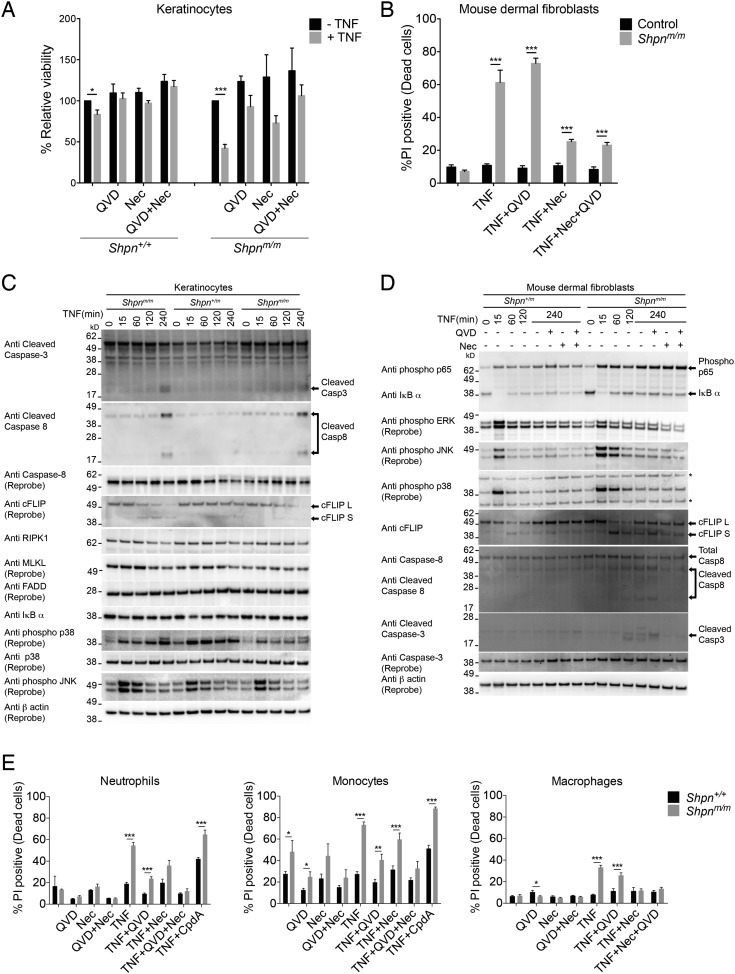
TNF induces death in multiple primary cell types, and is marked by caspase-3 and -8 cleavage in primary keratinocytes and mouse dermal fibroblasts in vitro.(A and B) Primary keratinocytes (A) and mouse dermal fibroblasts (MDFs) (B) were treated with 100 ng/ml human Fc-TNF, 50 µM Nec-1 or 10 µM Q-VD-OPh for 24 hr as indicated, then viability was assessed by propidium iodide (PI) uptake and flow cytometry. Cells were generated from three different mice for each group. Control: Shpn+/+ or +/m. (C and D) Western blot analysis of primary keratinocytes (C) and MDFs (D) treated as indicated (concentrations as in A and B) then lysed and lysates separated on SDS/PAGE and western blotted with indicated antibodies. Shpn+/m: n = 1; Shpnm/m: n = 2 (n = 1 for MDFs) mice analyzed shown above. * Indicates non-specific band. Data from additional mice is shown in Figure 4—figure supplement 1. (E) Neutrophils, monocytes and bone-marrow-derived macrophages were treated with 100 ng/ml human Fc-TNF, 50 µM Nec-1, 20 µM Q-VD-OPh (10 µM for macrophages) or 500 nM Compound A (CpdA) for 20 hr (24 hr for macrophages) as indicated. Viability was assessed by PI uptake and flow cytometry. The Smac mimetic CpdA sensitizes cells to TNF-induced cell death and serves as a control. Cells were generated from three different mice for each group except for macrophages, where six to eight mice were analyzed. (A, B, E) Data are represented as mean + SEM, *p ≤ 0.05, **p ≤ 0.01, ***p ≤ 0.005.